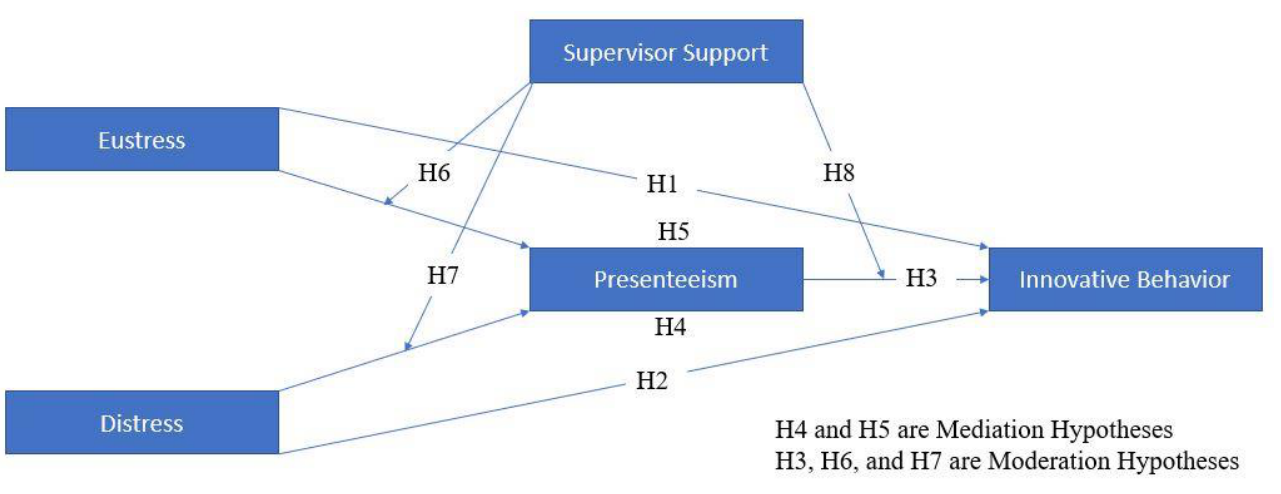
Figure 1. Proposed model of the study.